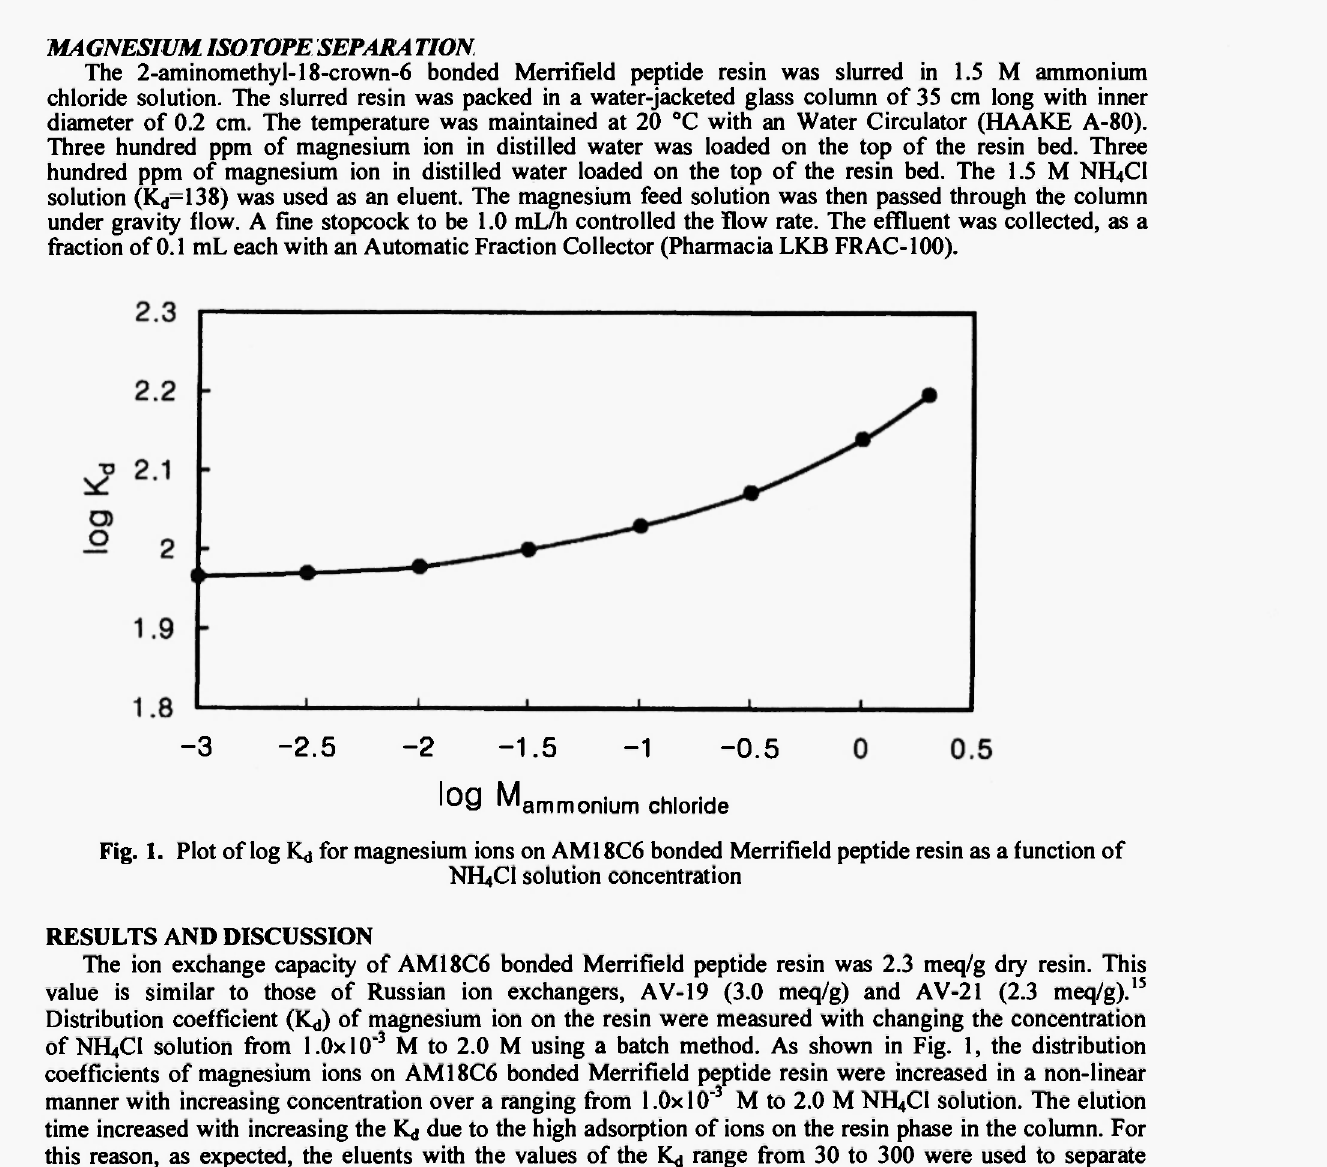
Fig. 1. Plot of log IQ for magnesium ions on AM18C6 bonded Merrifield peptide resin as a function of NH4CI solution